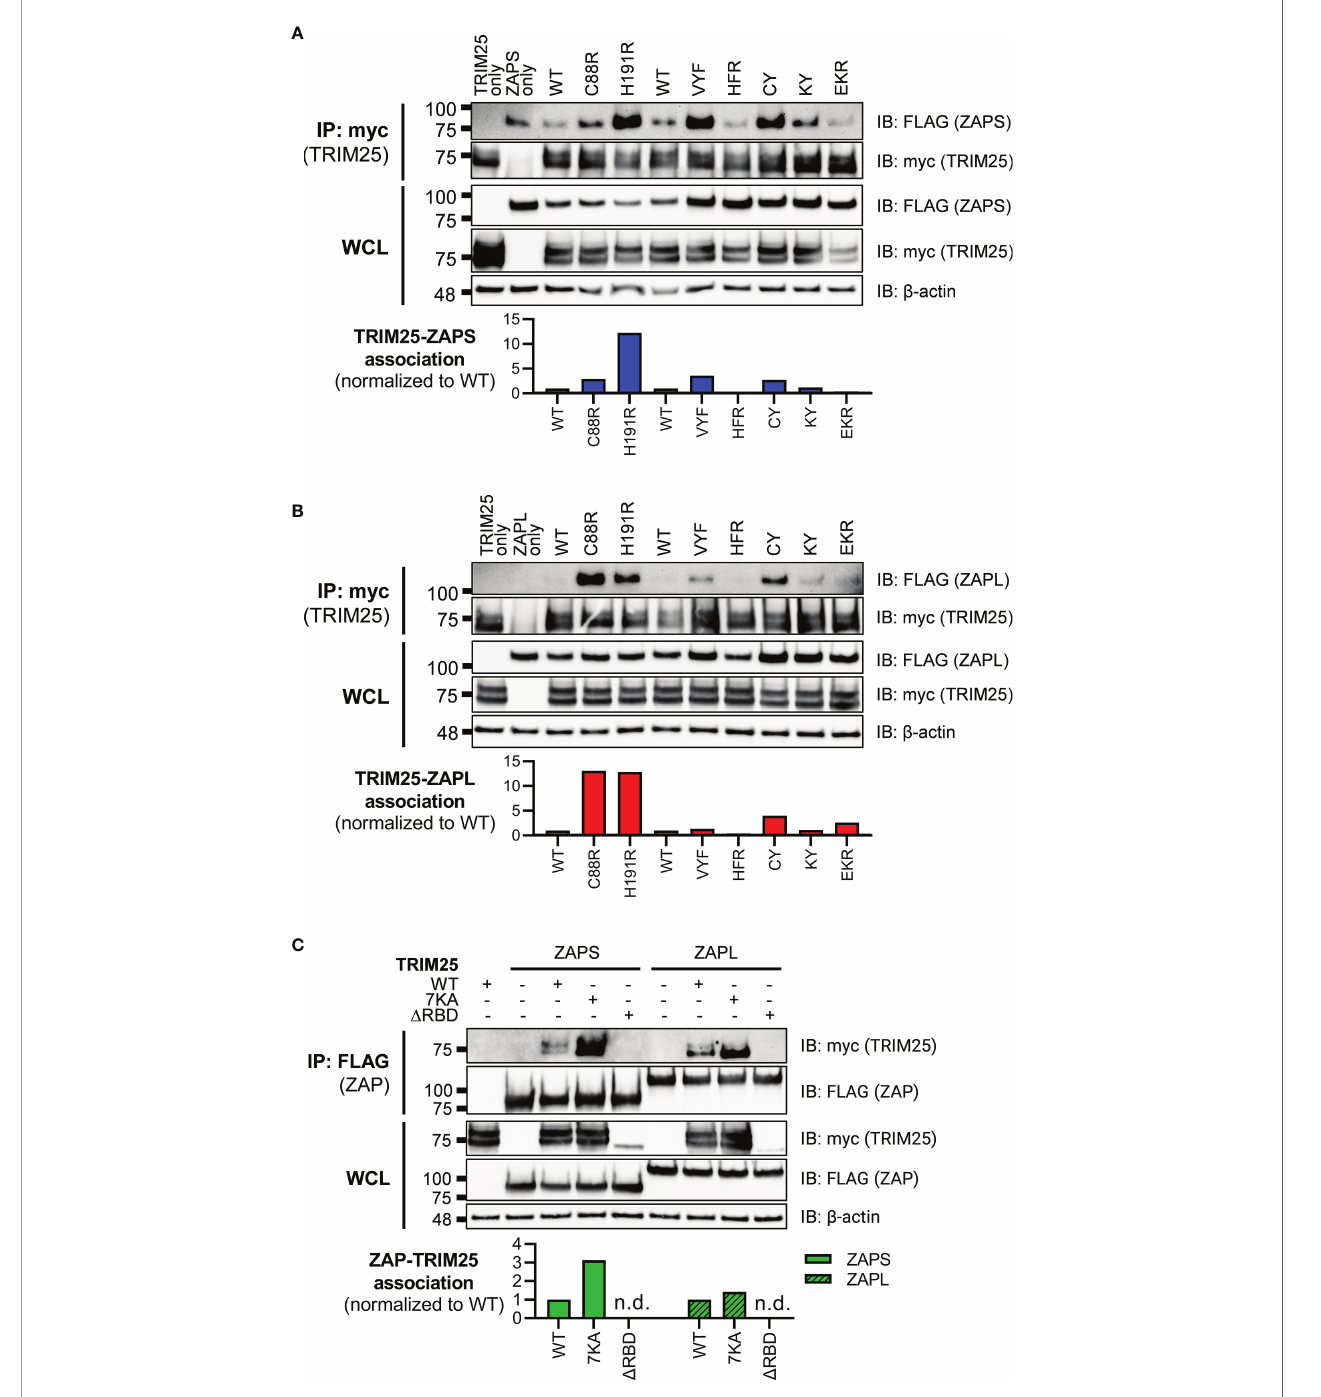
FIGURE 2 | Interaction of ZAP or TRIM25 RNA binding mutants with TRIM25 or ZAP WT. (A, B) Western blot of ZAP KO 293T cells transfected with myc-tagged TRIM25 and (A) FLAG-tagged ZAPS RNA binding mutants or (B) FLAG-tagged ZAPL RNA binding mutants. Different amounts of (A) ZAPS and (B) ZAPL WT were transfected to match protein expression levels for each subset of ZnF mutants and CpG RNA binding cavity mutants. Blots were quanti fi ed with ImageJ. Data are representative of two independent experiments. (C) Western blot of TRIM25 KO 293T cells transfected with FLAG-tagged ZAPS or ZAPL and myc-tagged TRIM25 RNA binding mutants; n.d. stands for not detectable by western blot. Blots were quanti fi ed with ImageJ. Data are representative of two independent